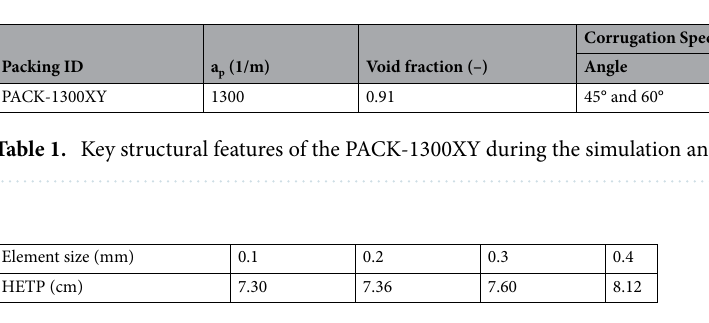
Table 2. Dependency of the HETP on the element size during the simulation analyses.